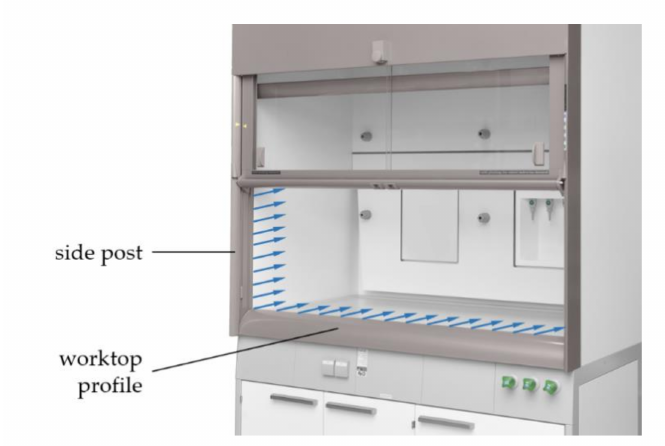
Figure 3. Wall jets blowing out of the frame profiles of the front opening—schematic representation.